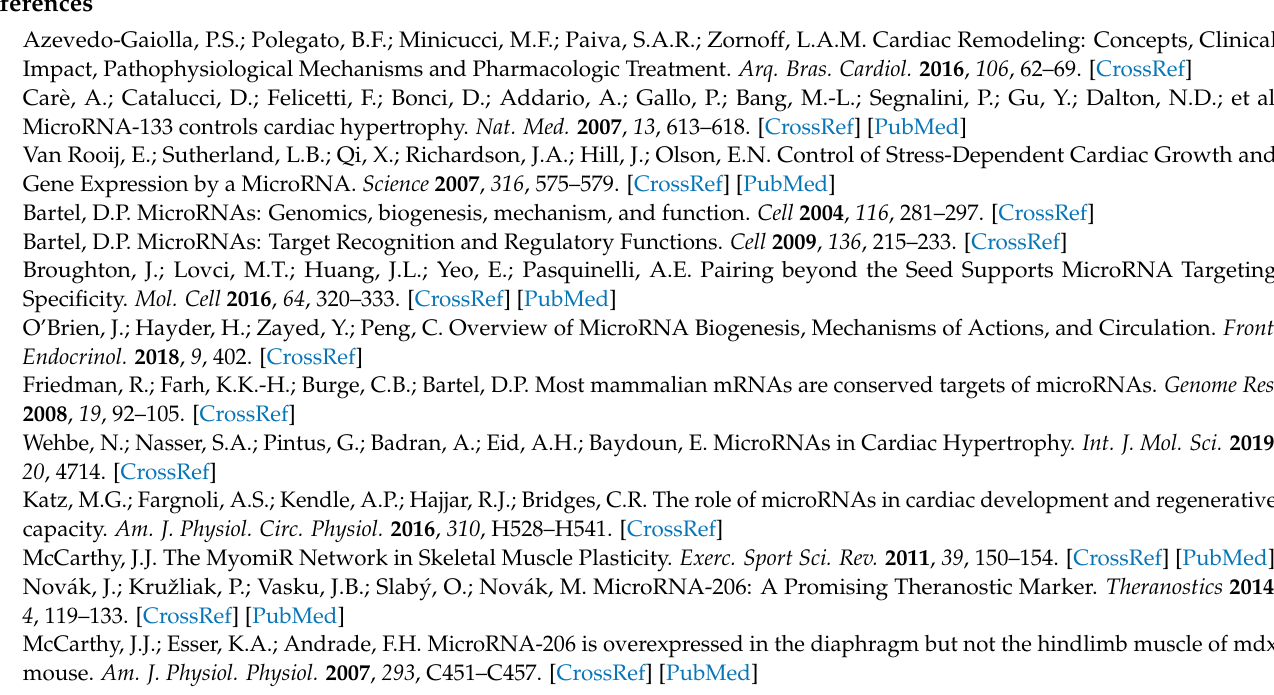
Table S3: Dual luciferase reporter gene constructs obtained from GeneCopoeia containing the 3 (cid:48) -UTRs of the L-type calcium channel subunits with the respective RefSeq gene accession number; Supplementary Figure S1: miR-208b, pri-miR-208b and myh7 expression in AII- or Iso-treated mice; Supplementary Figure S2: Expression of myh7 in whole-heart samples from male and female un- treated wild-type animals; Supplementary Figure S3: Expression of myh-6 in whole-heart samples from mice with severe heart hypertrophy in both genders; Supplementary Figure S4: Expression of myh6 in whole-heart samples of mice one week after birth, discriminated between male and female; Supplementary Figure S5: Potential target genes of miR-208b identified with a comparison of next-generation sequencing data; Supplementary Figure S6: 3 (cid:48) -UTR dual luciferase constructs for Kcnd2 and